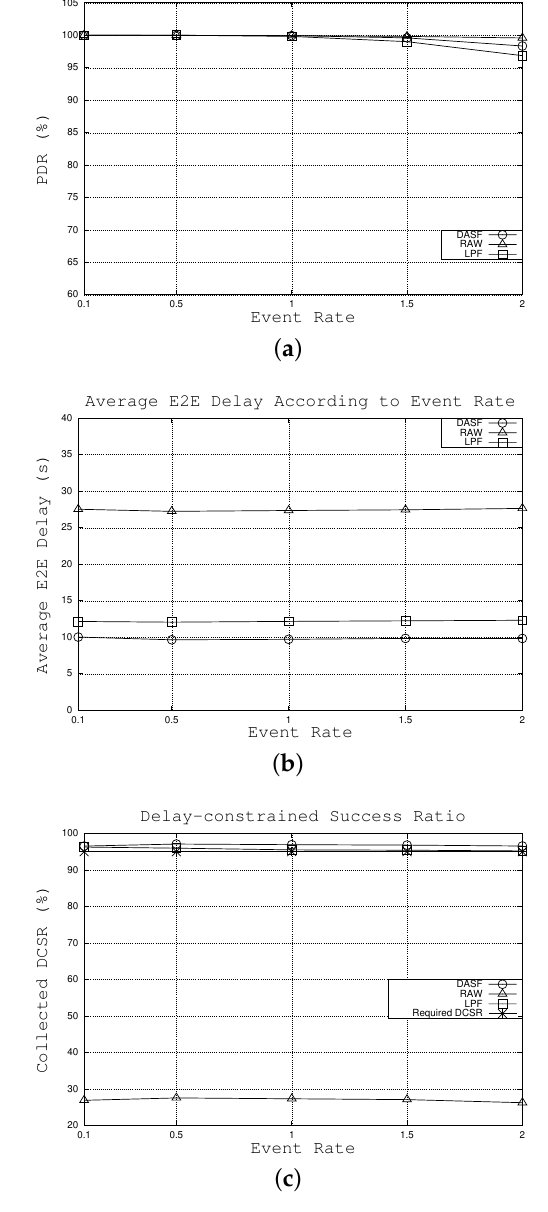
Figure 7. Effects of the event rate. ( a ) effects on packet delivery ratio, ( b ) effects on average E2E delay, ( c ) effects on collected